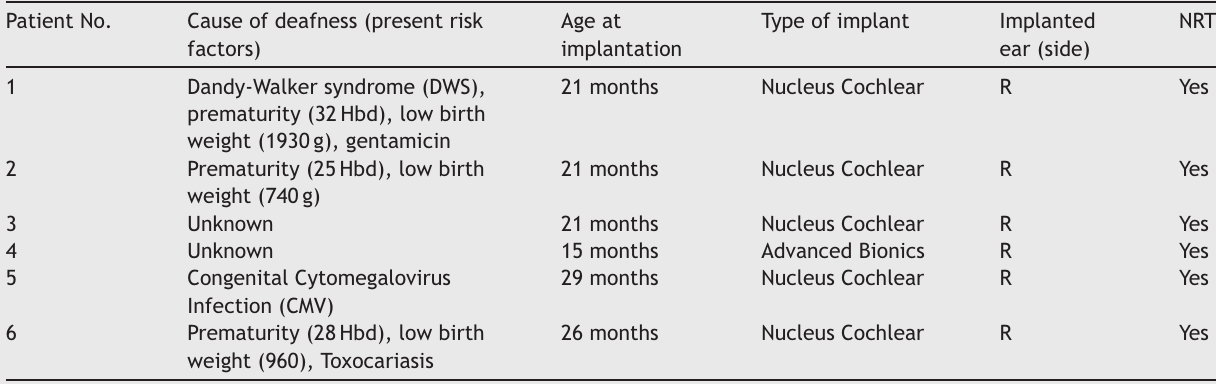
Table 1 Demographic information about implanted autistic patients. Patient